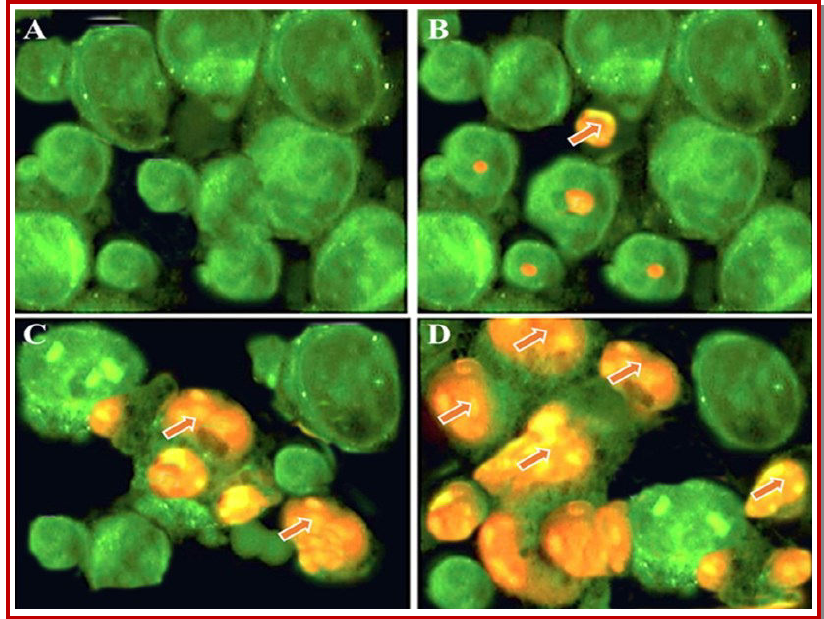
Figure 4: Evaluation of apoptosis induced by different doses of lactucin in HL-60 human leukemia cancer cells using fluorescence microscopy. The cells were treated without (A) and with 5 (B), 50 (C) and 100 (D) µ Μ of lactucin for 48 hours and then stained with acridine orange and ethidium bromide. Green fluorescence (A and B) indicate normal cells while as orange fluorescence (C and D) shows apoptotic